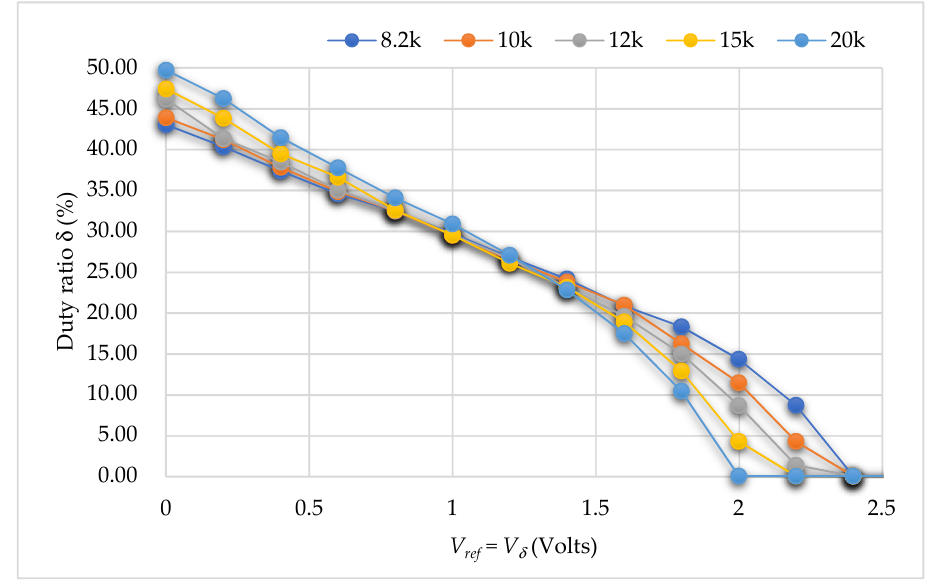
Figure 20. Influence of the resistance on the duty ratio vs. control voltage ( V δ ) in cCCDA letting ( C + cm , C − cm ) be (15 pF,15